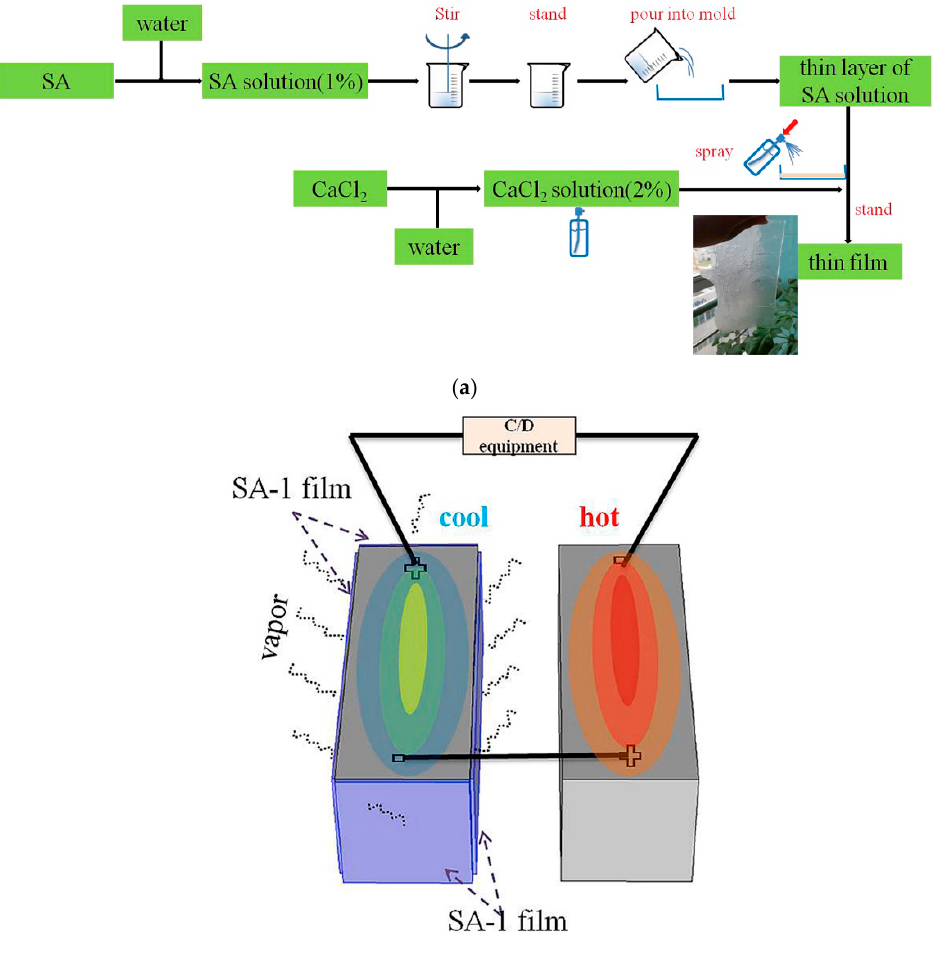
Figure 21. ( a ) The preparation process of thin sodium film (SA-1 film); ( b ) The application of SA-1 film in the system. Adopted from Ref. [248].